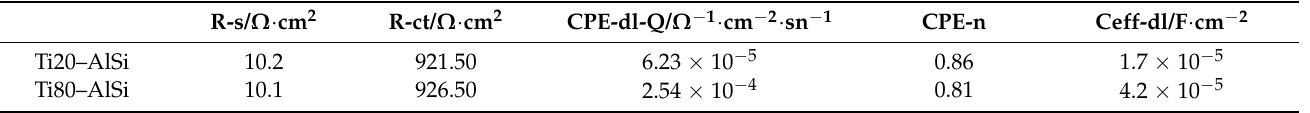
Table 4. EIS fitting results with attributions: s = solution; ct = charge transfer; dl = double layer. R-s/ Ω · cm